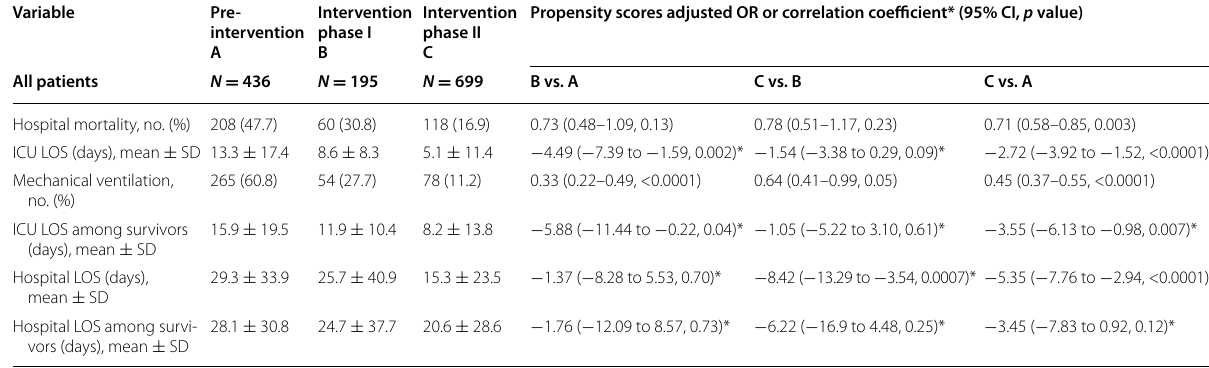
LOS length of stay, * correlation coefficient (95% CI, p value)